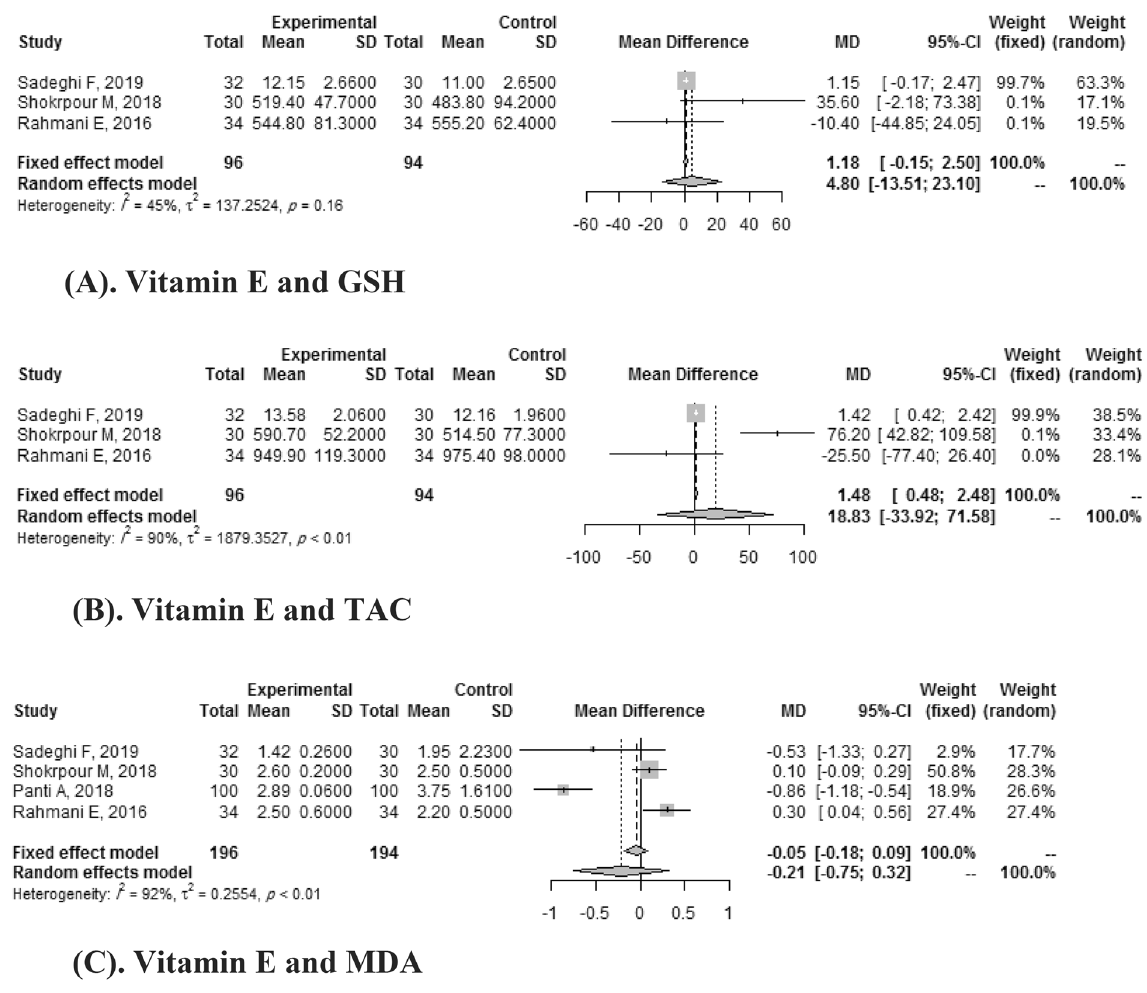
Figure 6. ( A ). Vitamin E and GSH. ( B ) Vitamin E and TAC. ( C ) Vitamin E and